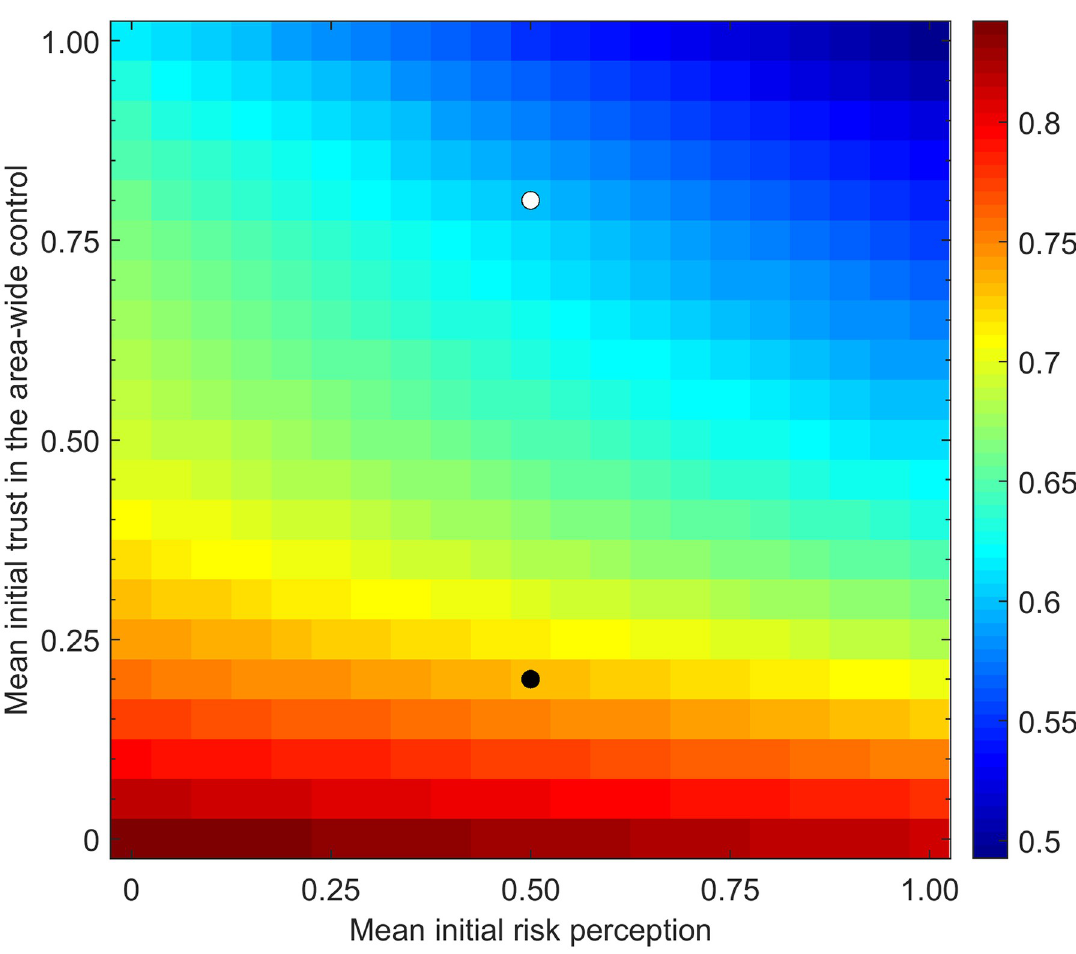
Fig 8. The probability of control failure considering grower initial risk perception versus trust in area-wide control. The white disc relates to the simulation shown in Fig 3a and the black disc to the simulation shown in Fig